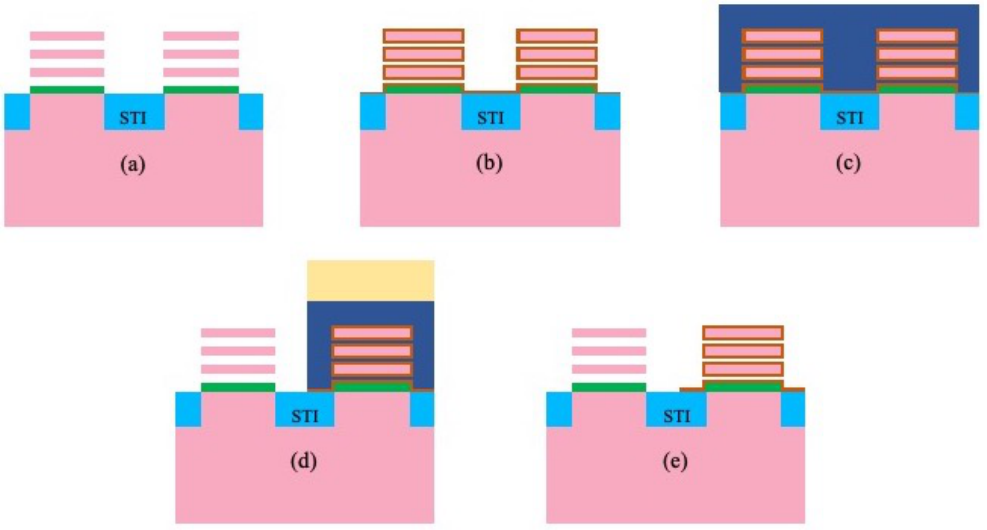
Figure 8. An example of V T modulation as presented in [21] is shown here. ( a ) The gate region post SiGe channel release; ( b ) WFM1 deposition; ( c ) sacrificial material deposition; ( d ) selective patterning and etch of the deposited WFM; and ( e ) removal of patterning stack resulting in a structure with WFM1 along one set of